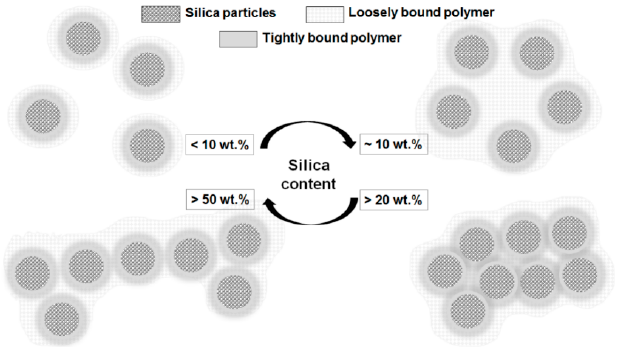
Figure 9. Tsagaropoulos’ schematic representation model of the morphological changes in the polymer matrix filled with silica filler in different concentrations: ( a ) less than 10 wt %; ( b ) circa 10 wt %; ( c ) over 20 wt % and ( d ) over 50 wt % (Redraw and adapted figure from [77]).